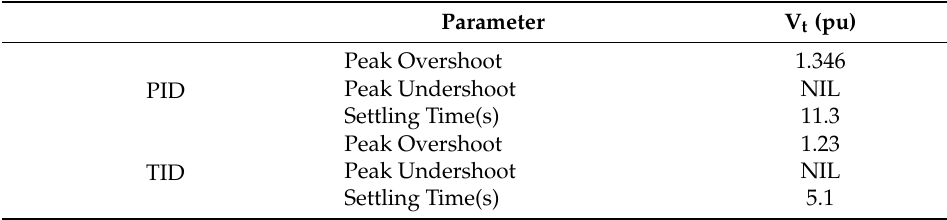
Table 14. Comparative dynamic measures with PID and TID controllers.